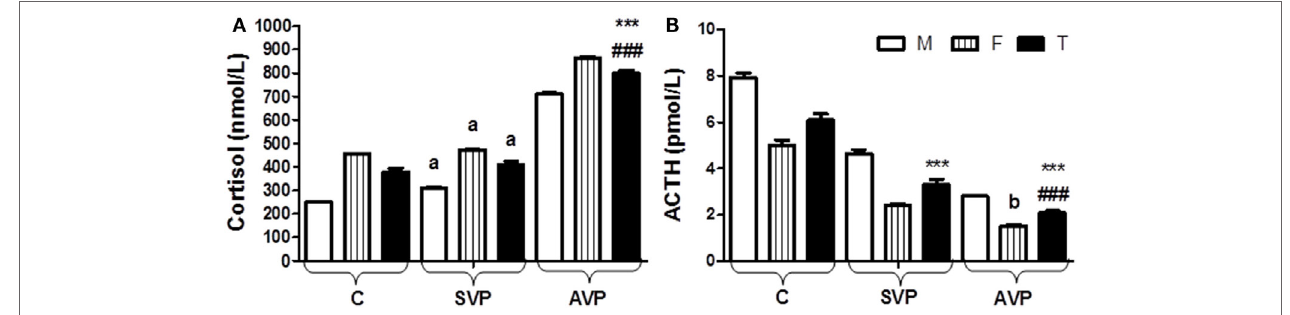
FigUre 6 | Serum levels of cortisol (a) and ACTH (B) in vitiligo patients compared with control subjects. Values expressed as mean ± SEM. *** p < 0.001 significant vs. Control. ### p < 0.001 significant vs. SVP, a; non-significant vs. control, b; non-significant vs. SVP (between groups Total vs. Total; Male vs. Male; Female vs. Female). Abbreviations: SVP, stable vitiligo patient; AVP, active vitiligo patient; M, male; F, female; T, total; ACTH, adrenocorticotrophic